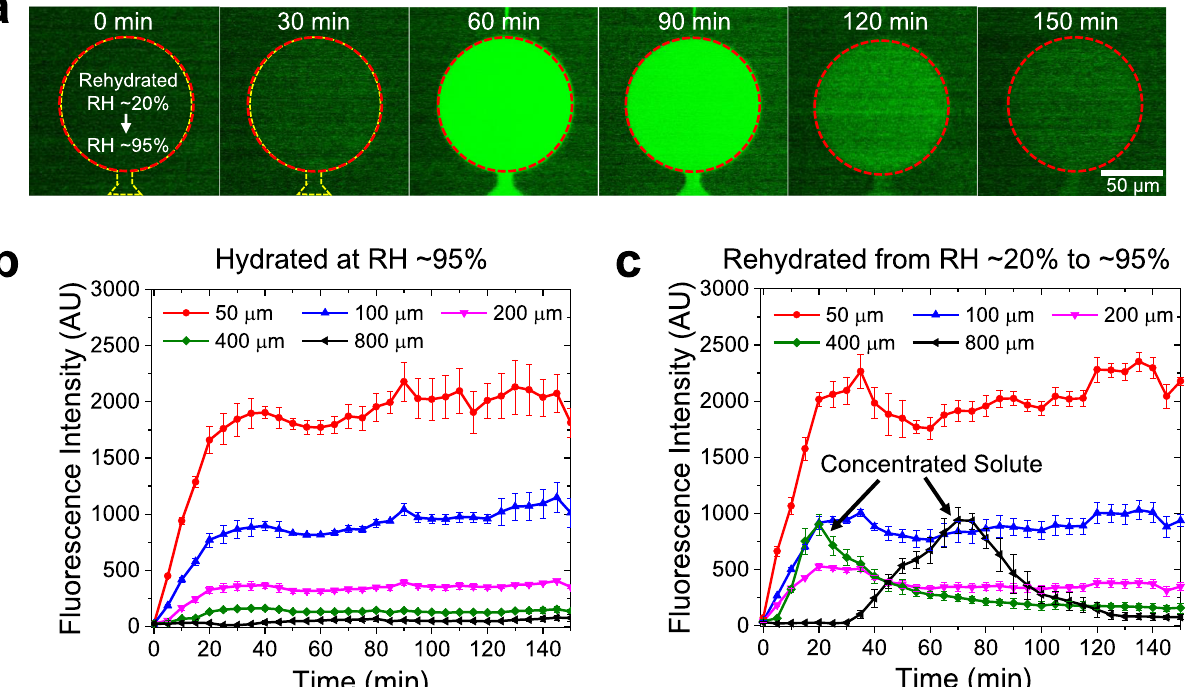
Fig. 2 Diffusive transport rate of the FITCs along the nanoslit in the GECMN, quanti fi ed using varying RH. a Quanti fi cation using the fl uorescence intensities (FIs) of the circular test chamber, which are acquired over time. Initially, the GECMN is exposed to an RH of ~20% ( t ≤ 0 min). Then, the RH changes to 95% (after t = 0 min) with the injection of the FITC solution, such that the FIs signi fi cantly increase. After the evaporation fl ux is fully prohibited and the concentrated solutes suf fi ciently diffuse, the FIs decrease. b For the completely hydrated condition (RH ~95%), injection of the FITC solution gradually increases the FIs for ~20 min and then plateaus regardless of the nanoslit length. c Under the same conditions as those in ( a ), injection of the FITC solution induces the concentration of the solute as shown in the 400 and 800 μ m nanoslits but induces a plateau as in ( b ) for the short nanoslits (50, 100, and 200 μ m). All error bars represent the standard errors on the means ( n =